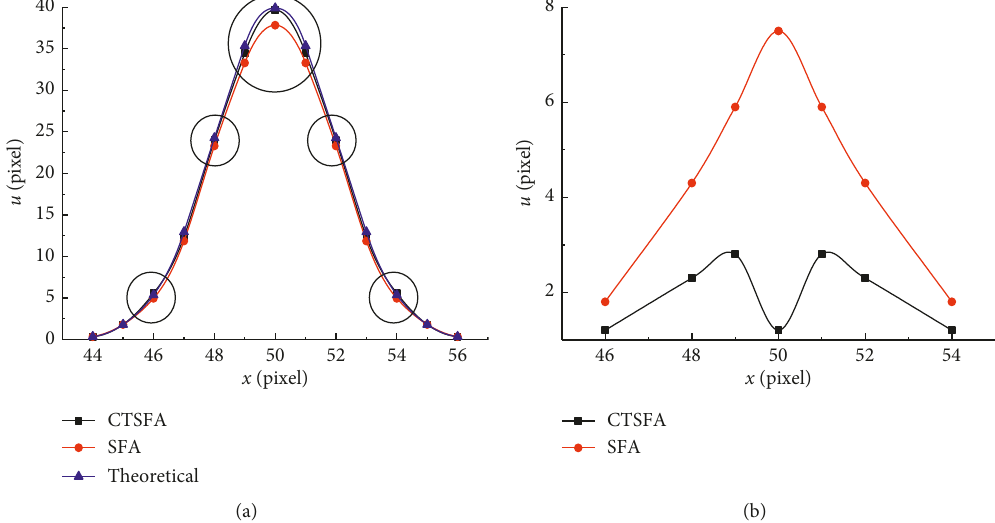
Figure 9: Results of nonuniform displacement field. (a) Comparison of displacement values. (b) Comparison of relative